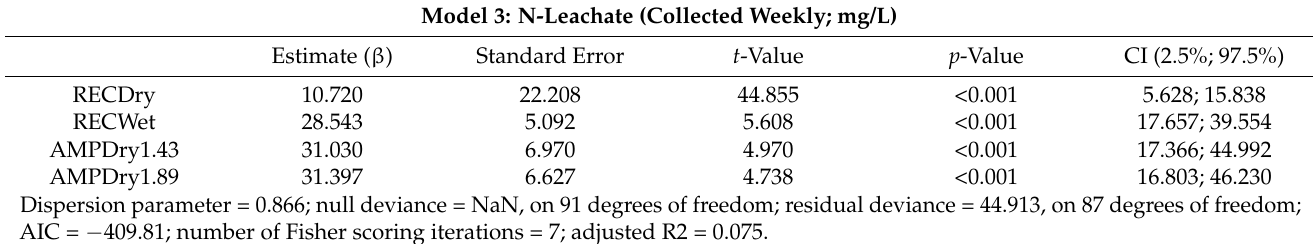
Table 3. Estimated regression parameters, standard errors, coefficients and p -values for 2 gamma GLMs.